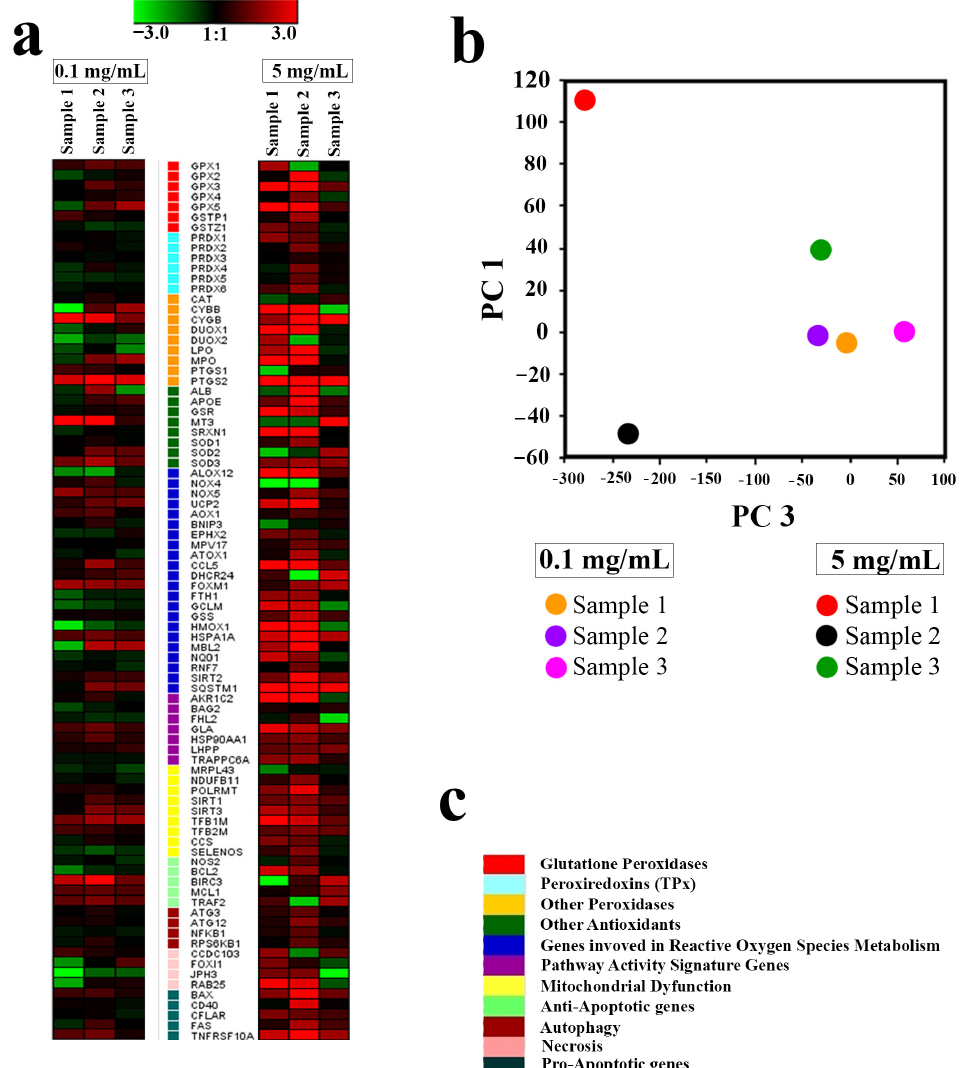
Figure 10. Heat maps of gene expression in hMScs treated with Ce 0.8 Gd 0.2 O 2 − x NPs (0.1 and 5 mg/mL) after 24 h of incubation ( a ). The intensity scale of the standardised expression values ranges from 3 (green: low expression) to +3 (red: high expression), with a 1:1 intensity value (black) representing the control (non-treated). A principal component analysis (PCA) of RT-PCR data for the cells treated with samples of Ce 0.8 Gd 0.2 O 2 − x NPs ( b ). Cluster groups of genes and their functionality ( c